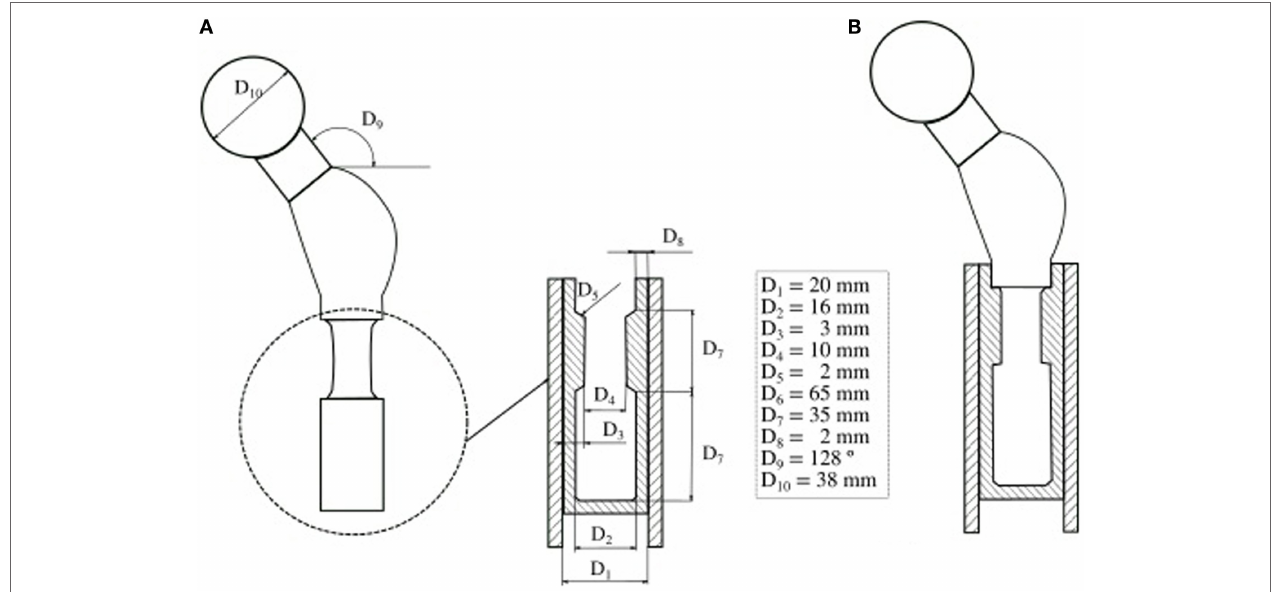
FIGURE 2 | Probabilistic design of a cemented hip prosthesis, adapted from (Kayabasi and Ekici, 2008) . (A) Geometry of a hip prosthesis and variable design parameters. (B) New design parameters which reduce the probability of failure.